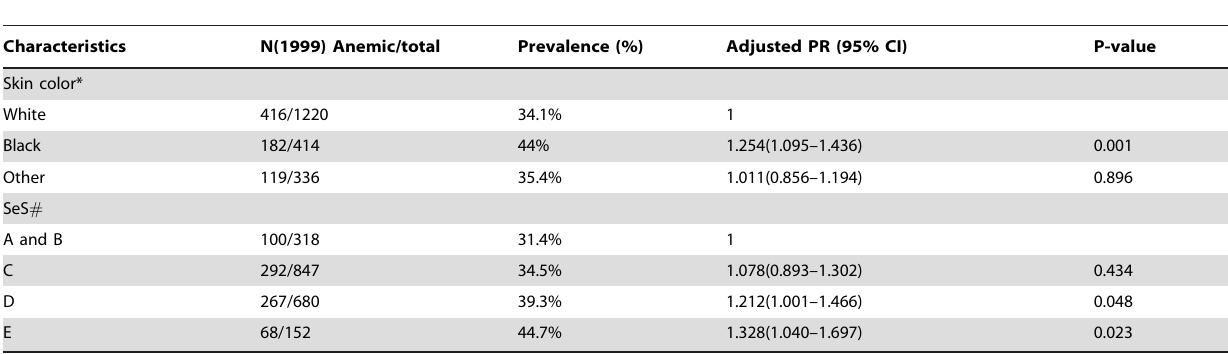
Table 4. Hierarchic Multiple Poisson Regression analysis of the predicting factors for anemia in women, RS, Southern Brazil, 2006–